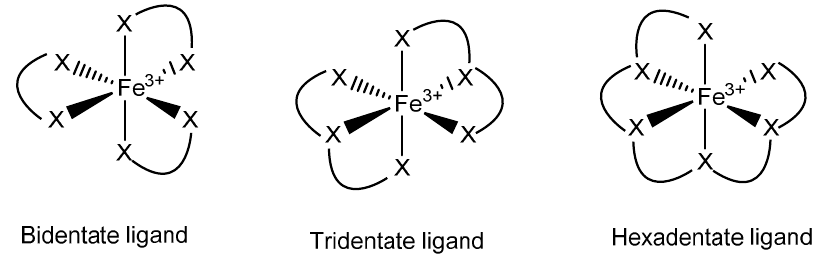
Figure 8. General Fe(II) and Fe(III) coordination by bidentate, tridentate, and hexadentate chelators to satisfy 6-coordinate structures.